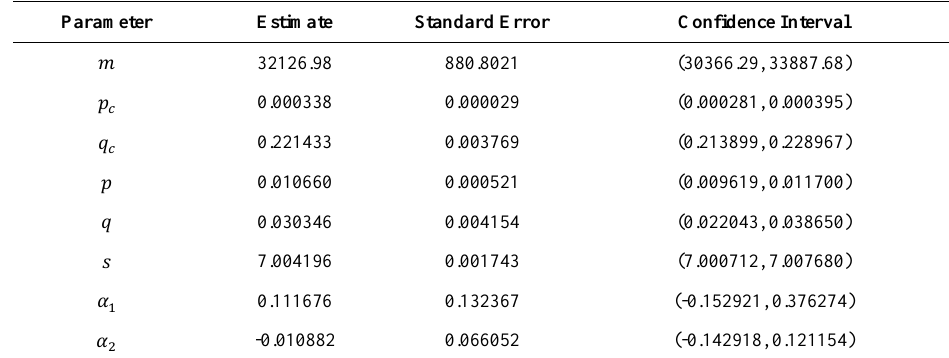
Table A28. Emilia–Romagna. Estimates, asymptotic standard errors and 95% mCIs for the parameters of the DMPseas